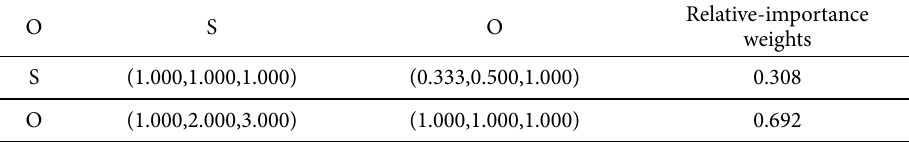
Relative-importance weights